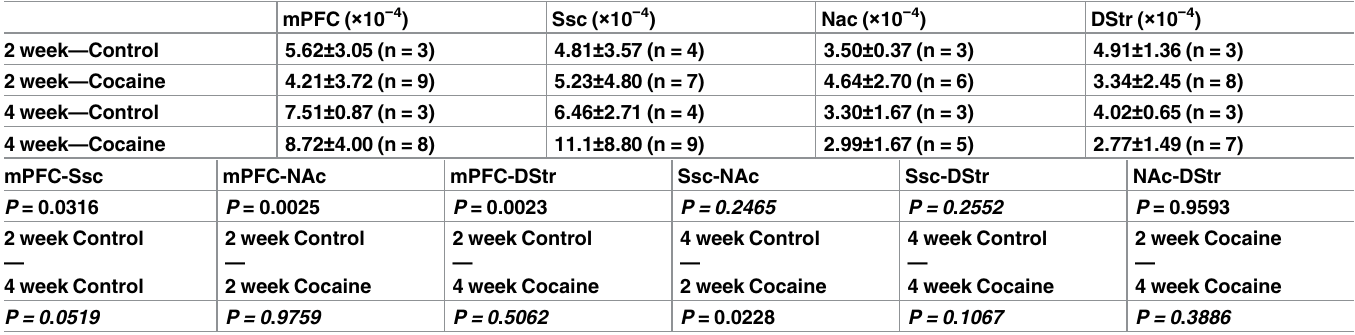
Table 4. HIF-1 α expression (mean ± Std) in different brain regions including mPFC, Ssc, NAc and DStr, following cocaine treatment for 2 weeks and 4 weeks. P values calculatedusing two-way ANOVA (SAS) are listed below. Significant P values ( P < 0.05)are bolded.